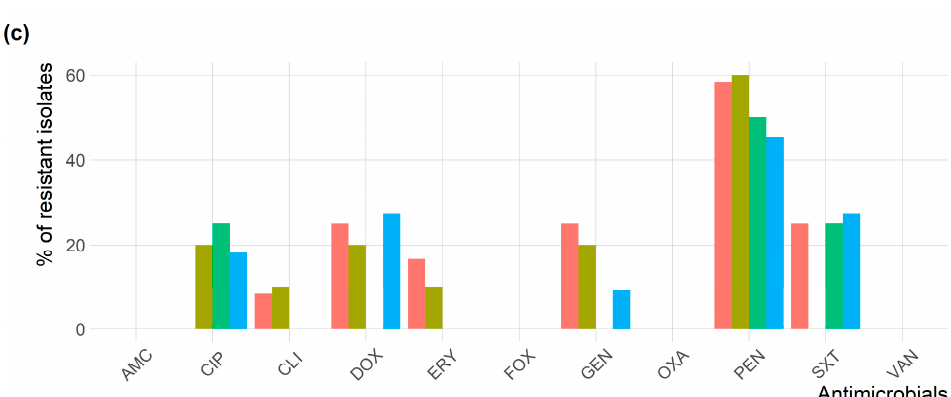
Figure 2. Frequency of antimicrobial resistance of ( a ) Escherichia coli ; ( b ) Salmonella typhimurium ; and ( c ) Staphylococcus spp. recovered from different species of migratory wild birds around the Al-Asfar Lake.